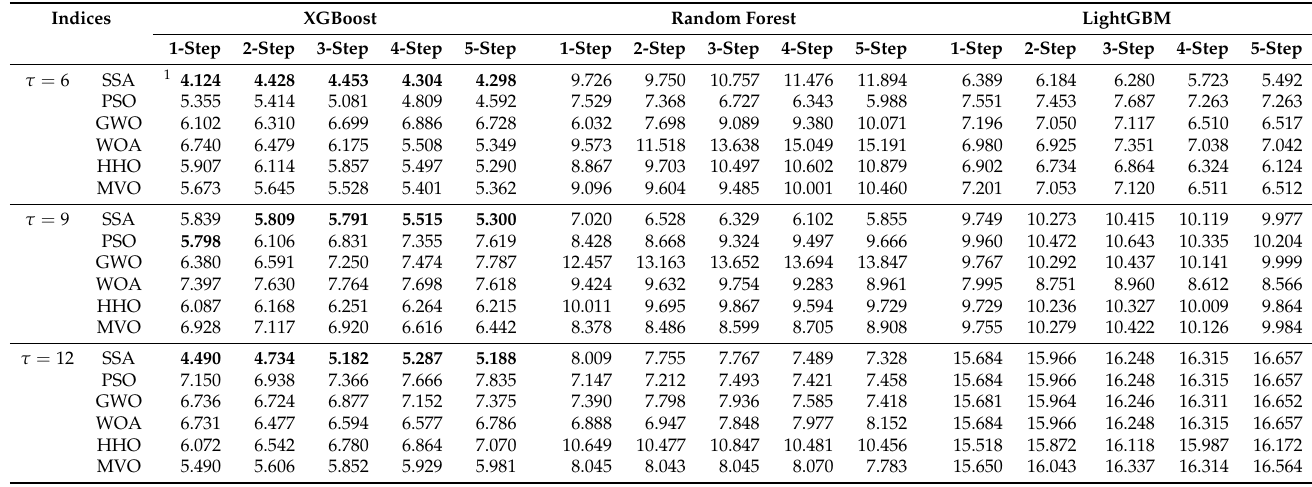
Table 5. MAPEs of multi-step ahead forecasting of the NGC of UK.